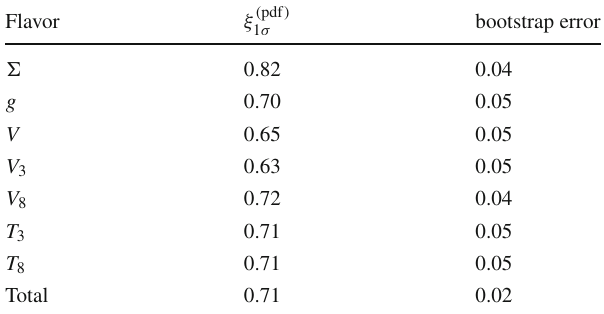
Table 26 The one-sigma Experiment quantile estimator in the space ( data ) of experimental data, ξ 1 σ Eq. (6.17) and evaluated for the same testing dataset as used for Table 25, together with the corresponding bootstrap error. For each group of processes, we also display the value of √ erf ( R b v / 2 ) evaluated using the corresponding bias-to-variance ratio